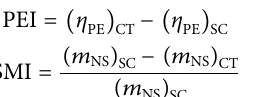
Frontiers in Energy Research |